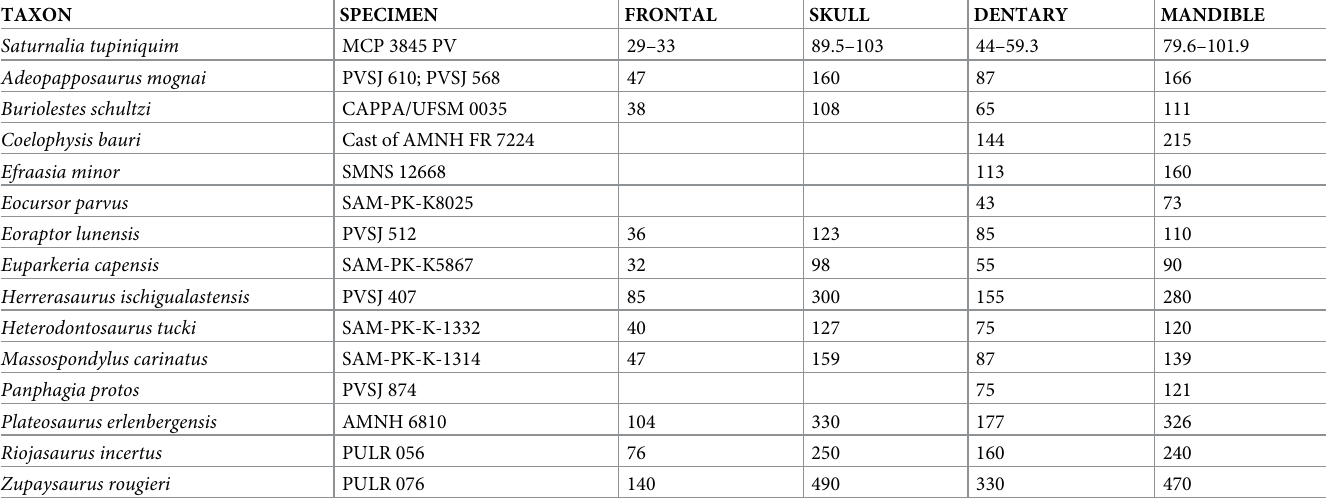
Table 1. Frontal, skull, dentary, and mandible lengths of Late Triassic and Early Jurassic dinosaur taxa, and the archosauriform Euparkeria. Skull and mandible lengths for the specimen MCP-3845-PV of Saturnalia tupiniquim correspond to the values obtained using linear regression based on the values for the other taxa listed (see details in the Material & methods